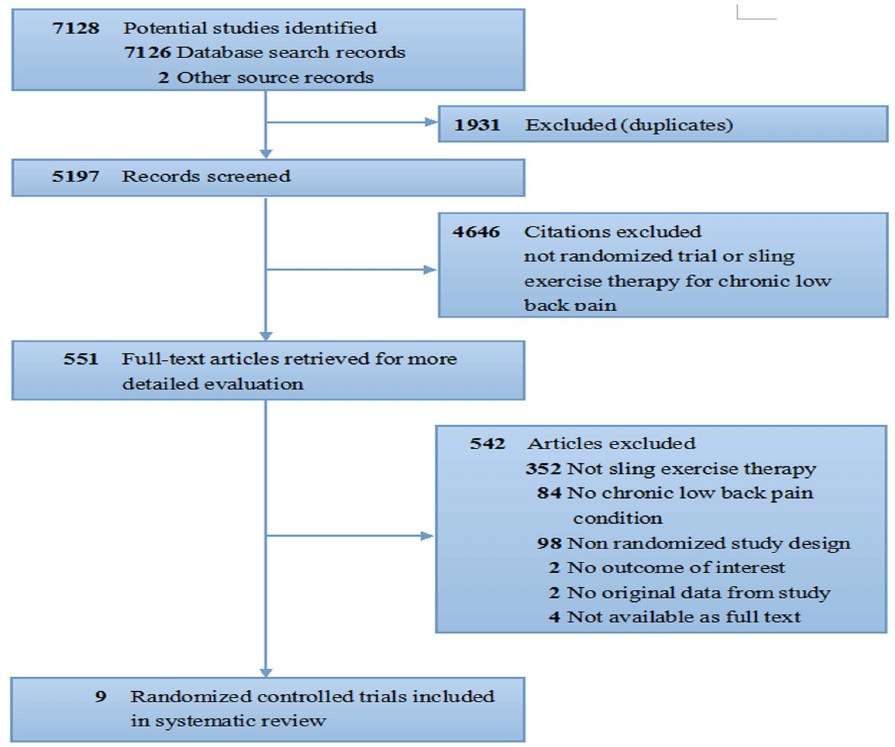
Figure 1. Review flow diagram.